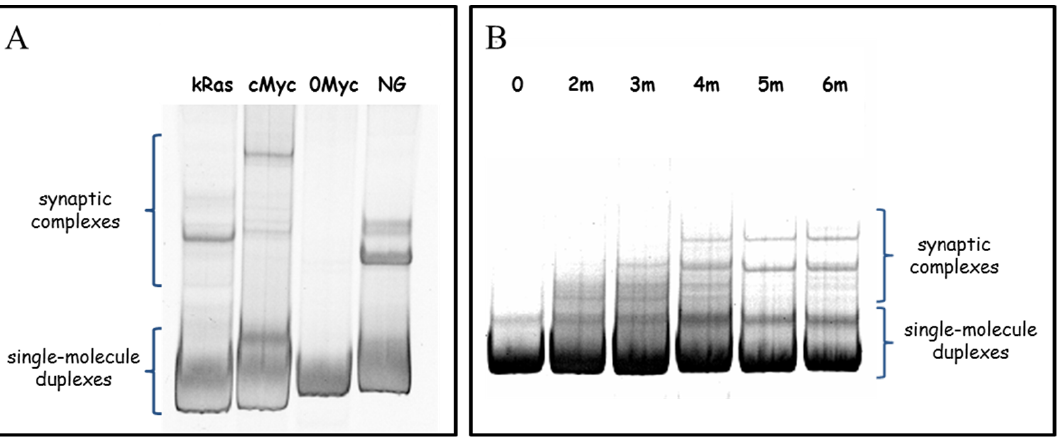
Figure 9. Non ‐ denaturing PAGE of natural DNA amplicons ( A ) and model set of duplexes ( B ). Figure 9. Non-denaturing PAGE of natural DNA amplicons ( A ) and model set of duplexes ( B